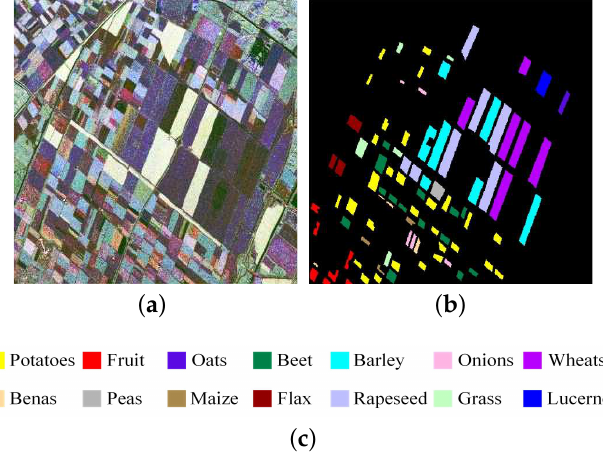
Figure 4. Flevoland datasets of 14 classes. ( a ) Pauli RGB. ( b ) Ground-truth map. ( c )